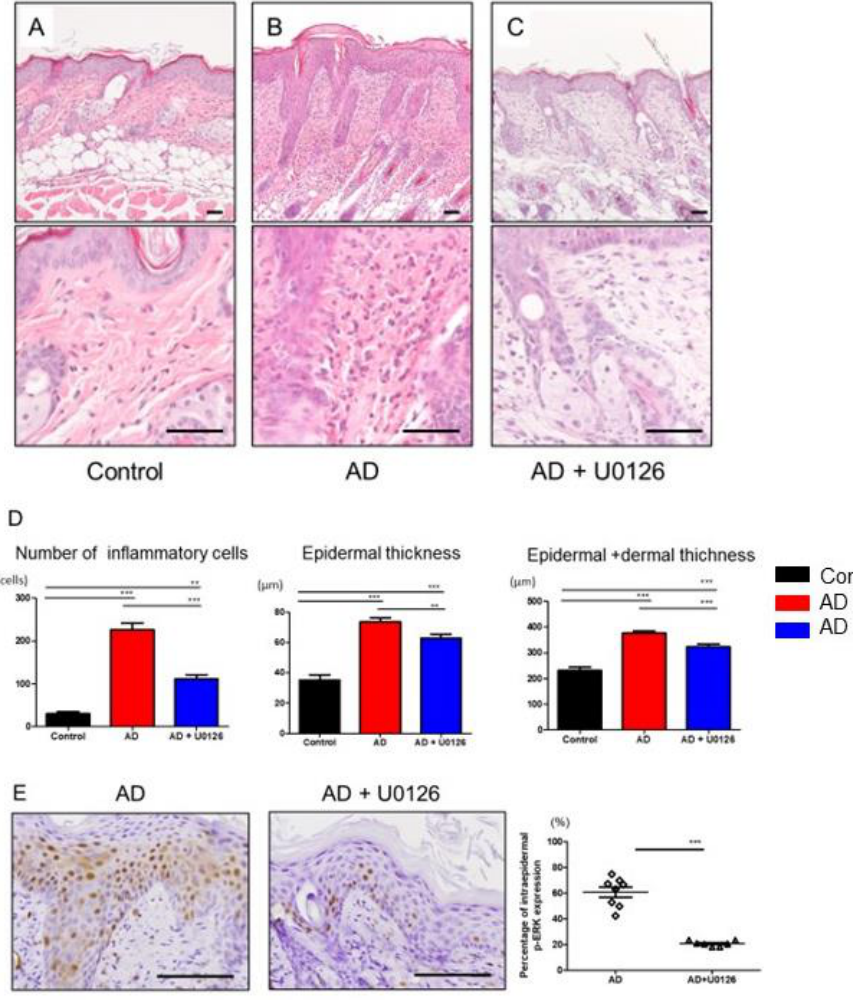
Figure 3. Topical application of ERK inhibitor improves the histological changes of mite antigen- induced AD in mice. Histological appearance (hematoxylin-eosin staining) of skin lesions of control ( A ), AD ( B ), and AD + U0126 ( C ) groups on day 7. Scale bar: 50 µ m. ( D ) Number of total inflammatory cells in dermis on the dorsal skin of mice. Measurements of epidermal thickness and epidermal + dermal thickness ** p < 0.01, *** p < 0.001 one-way analysis of variance followed by Bonferroni’s multiple comparison test. ( E ) Immunohistochemical staining for intraepidermal p-ERK expression of skin lesions of AD and AD + U0126 groups. Scale bar: 100 μm. , *** p < 0.001 Student’s unpaired two-tailed t -test on each day. All data are presented as mean ± S.E.M. (n = 3 control group, n = 8 AD group, n = 8 AD + U0126 group)